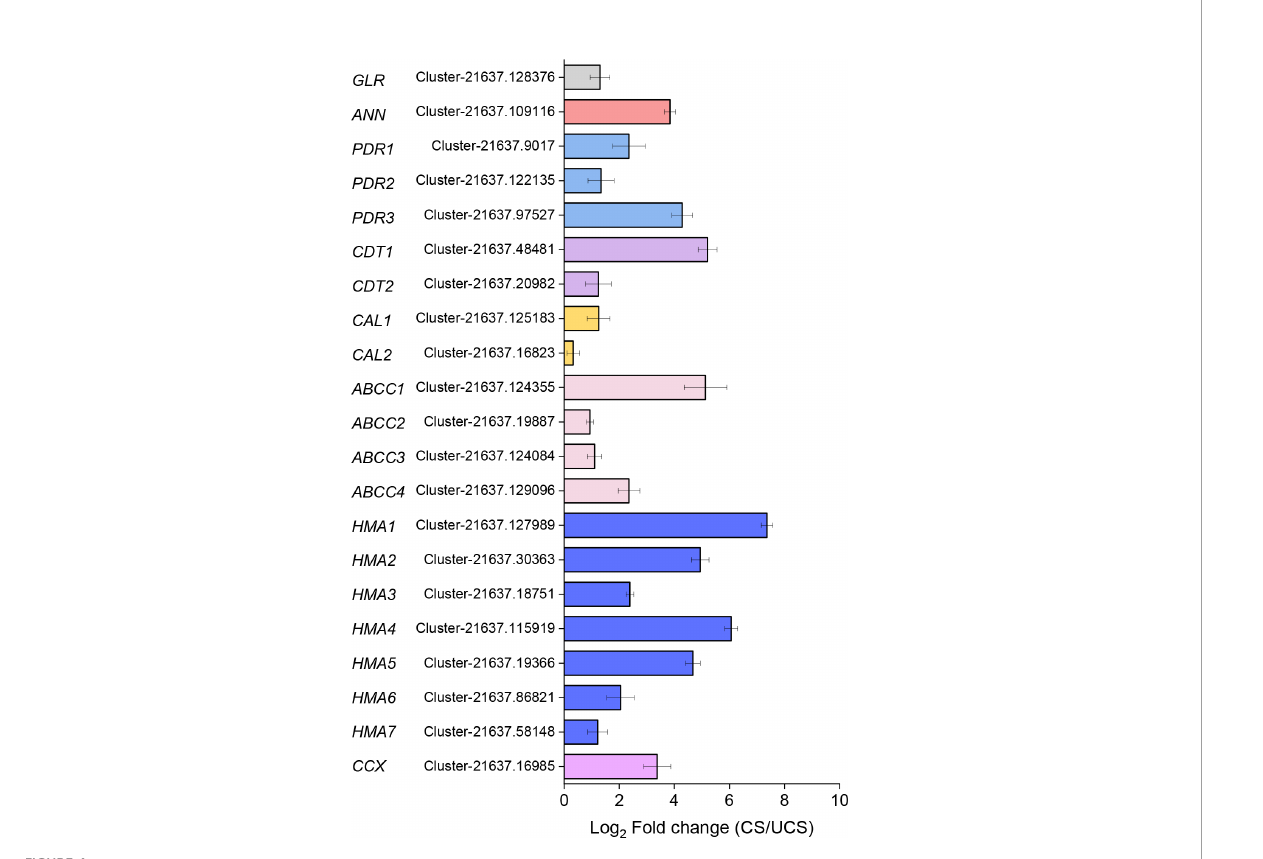
FIGURE 4 The relative gene expression levels of transporters/proteins involved in Cd accumulation under CS treatment as determined by